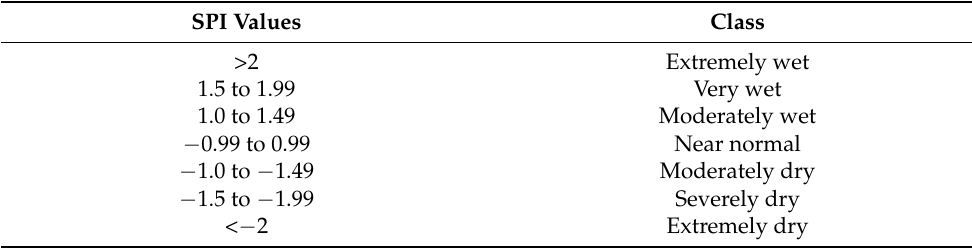
Table 1. Classification of drought based on SPI [57].